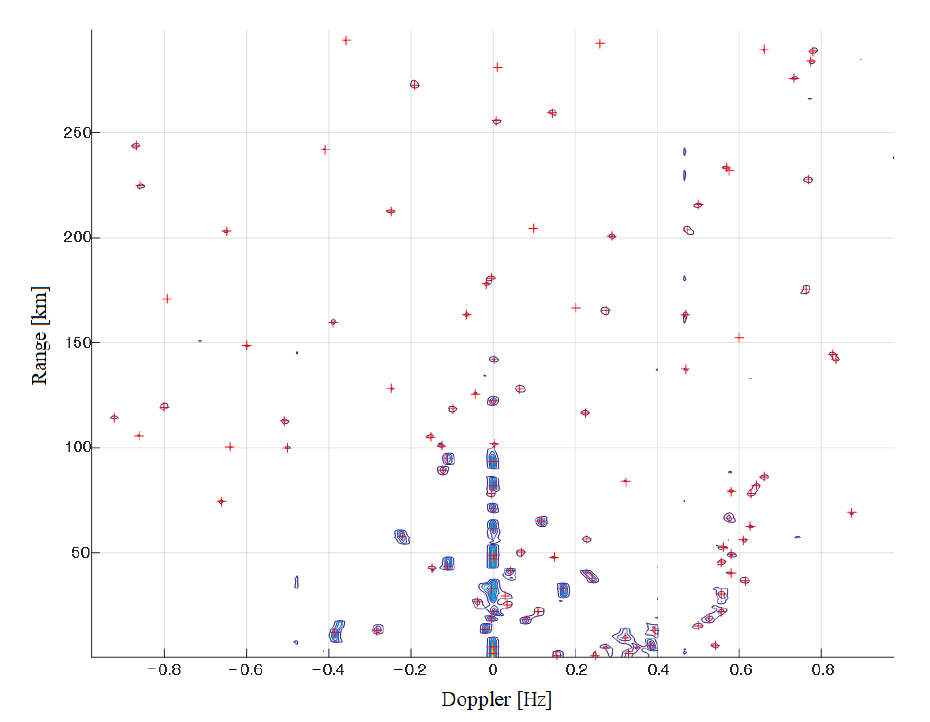
Figure 13. Detections on RD-HR map (detections are denoted by ”+” markers, and the blue contours represent the contours of the criterion function of the MUSIC-based